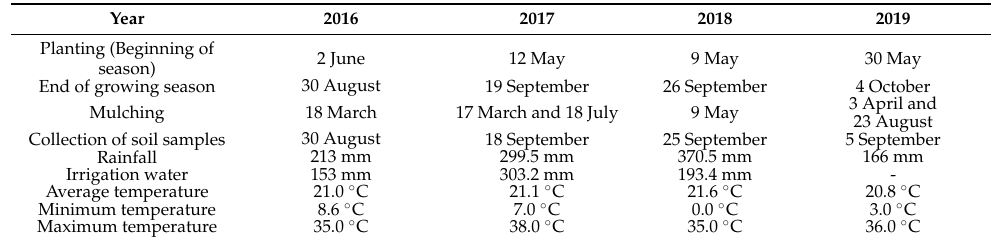
Table 1. Timeline of actions and weather conditions during the growing seasons of our study years (2016–2019, Gödöll˝o,